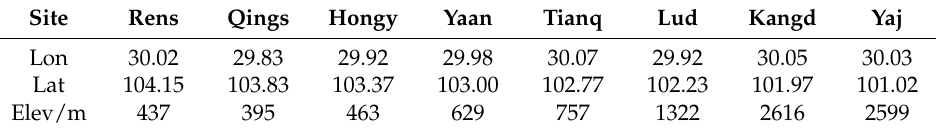
Table 2. The weather sites of the latitudinal elevation transect crossing the study